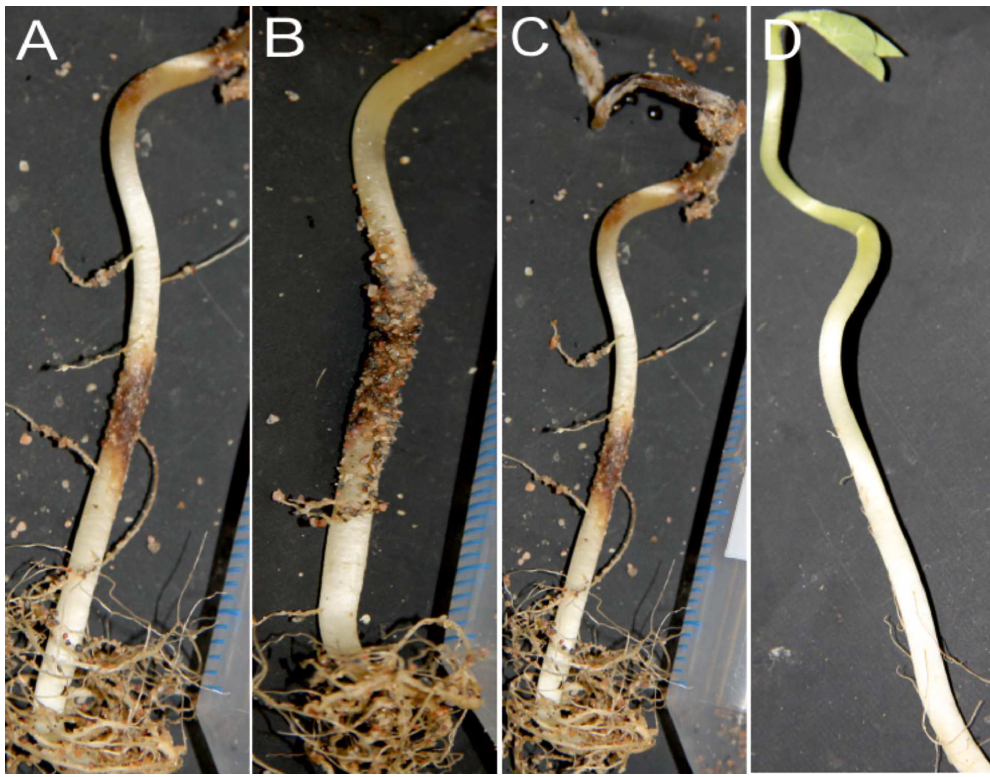
Fig 3. Symptoms of lima bean seedlings caused by fungal isolates of phenogroup IV. (a) to (c), inoculated plants at 20 dpi, and (d), non-inoculated control. Necrosis in the middleof the stem corresponds to the position of inoculumplaced in the test tube. All inoculated seedlingsdisplay severe apical